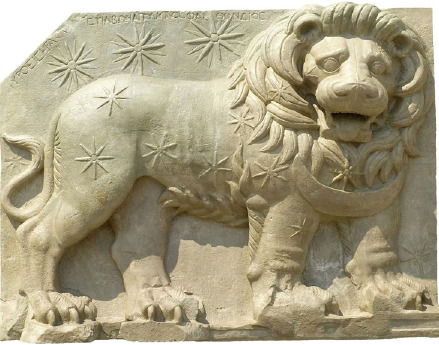
Fig. 5 The Lion horoscope. A complete copy of the original stele as found, donated by the International Nemrud Foundation to the Pierson Museum in Amsterdam, The Netherlands. Photo by Maurice Crijns. This fi gure is not covered by the Creative Commons Attribution 4.0 International License. rights